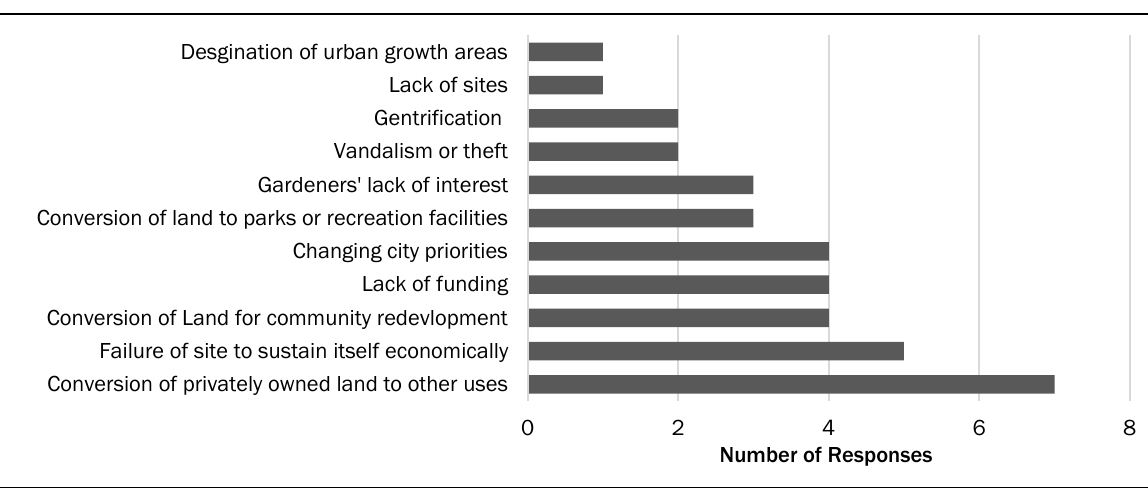
Figure 3. Reported Reasons for Urban Agriculture Decline ( n